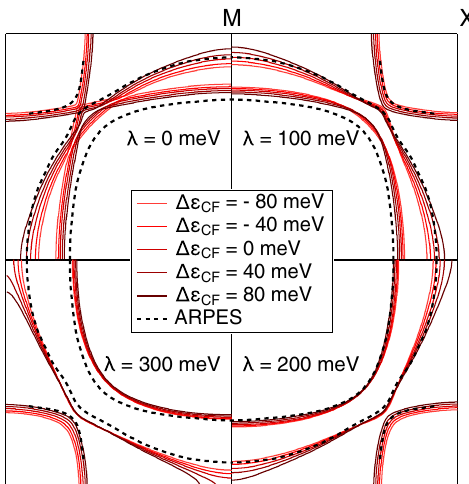
FIG. 11. Fermi surface of Sr 2 RuO 4 for λ ¼ 0 meV (top left), λ ¼ 100 meV (top right), λ ¼ 200 meV (bottom right), and λ ¼ 300 meV (bottom left) compared to ARPES (dashed black line). Note that λ ¼ 100 meV corresponds to a DFT þ SOC calculation and λ ¼ 200 meV to an effective SOC enhanced by electronic correlations (see main text). The different shades of red indicate additional crystal-field splittings Δ ϵ ϵ 85 meV of ˆ H DFT . cf ¼